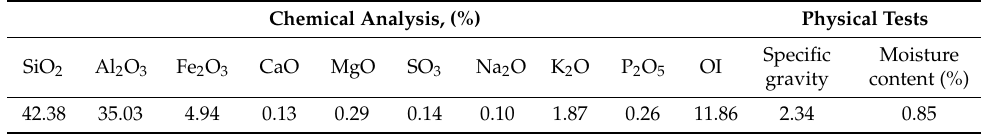
Table 1. External properties and aluminum sludge chemical composition. Chemical Analysis, (%)